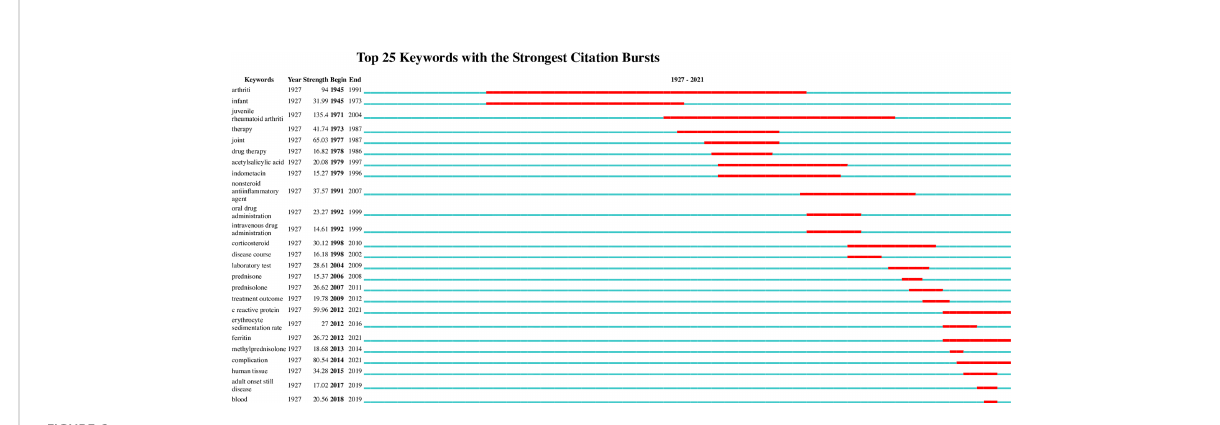
FIGURE 6 Top 25 keywords with the strongest citation bursts of adult-onset Still ’ s disease articles from 1921 to